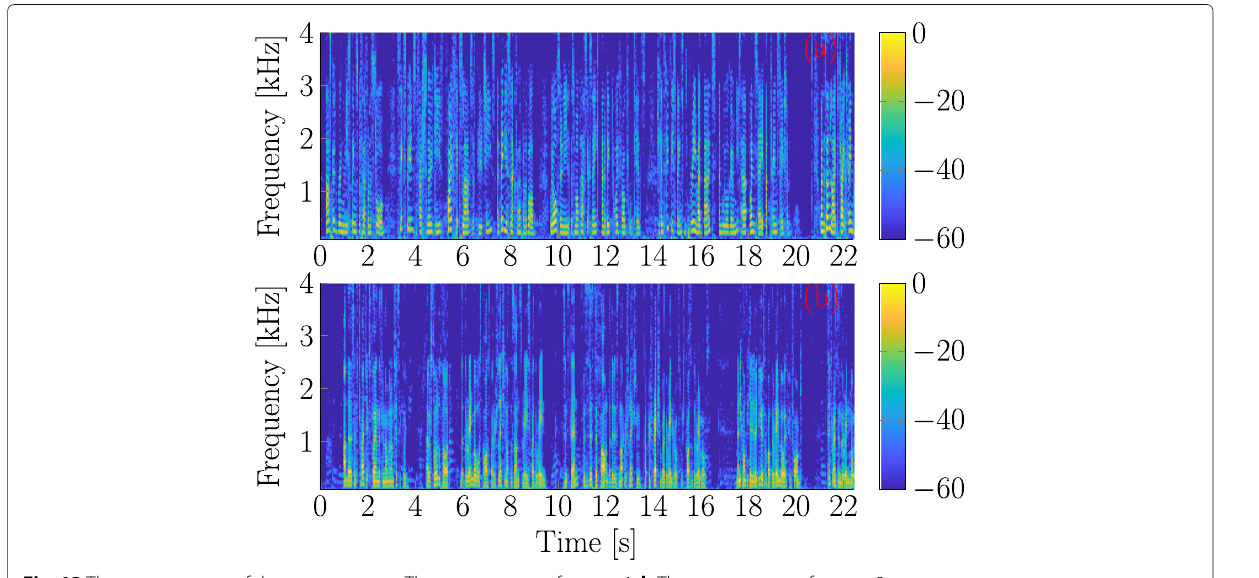
Fig. 12 The spectrograms of the two sources. a The spectrogram of source 1. b The spectrogram of source